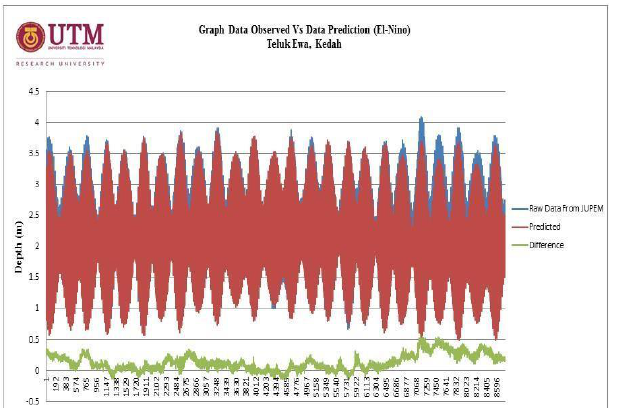
Figure 23. Graph of Comparison between Data Observed and Data Prediction